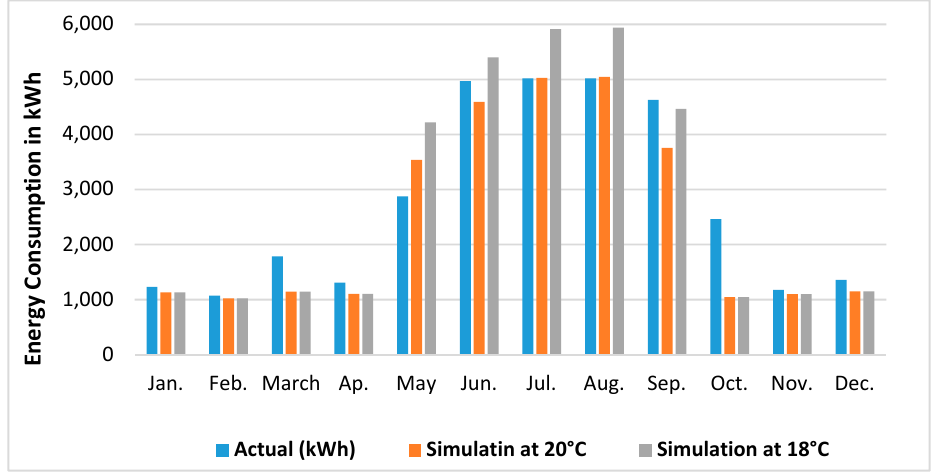
Figure 9. The actual reading and simulation results of the energy consumption of the air-conditioning (AC) with thermostat settings of 18 °C and 20 °C.